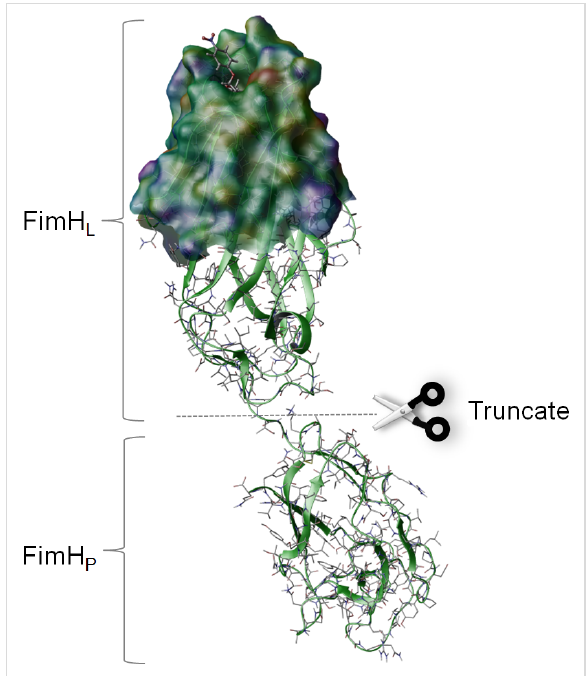
Figure 2: FimH crystal structure (pdb code 1KLF) with docked p -nitro- phenyl α -D-mannopyranoside ( 1 , p NPMan). FimH is a two-domain pro- tein comprising a lectin domain (FimH L ) with the carbohydrate binding site (top) and a pilin domain (FimH P , bottom) that anchors the lectin onto the fimbrial shaft. For photoaffinity labeling, a truncated version of the protein (FimH tr ) was used. The carbohydrate binding site is depicted as Connolly surface and colored according to the electro- static potential. The picture was generated with glide and rendered with maestro, both implemented in Schrödinger